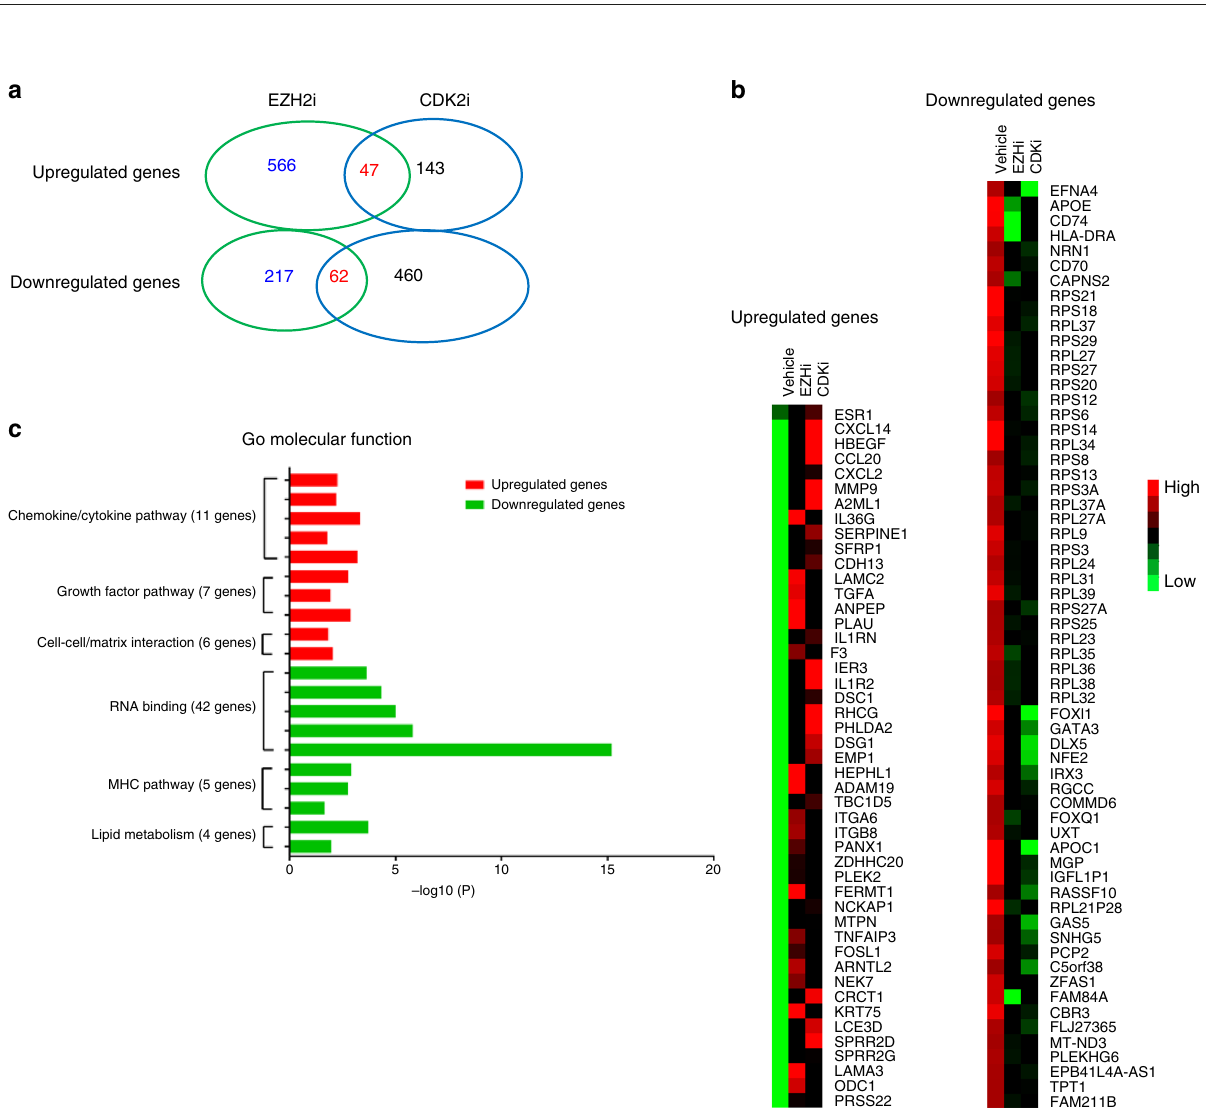
Fig. 4 CDK2/EZH2 blockade creates combination regimen with tamoxifen against TNBC. a Effective inhibition of TBNCs in 3D cultures by combination treatment of CDK2/EZH2 inhibitors (EPZ, GSK; SNS, and DINA) and TAM determined by 3D-Matrigel sphere formation assays. Representative images (upper panel) and bar graph of sphere numbers (bottom panel). Scale bar, 200 μ m. b , c Synergistic effect of combination treatment of the TNBCs in vitro with CDK2/EZH2 inhibitors and TAM b or fulvestrant, Ful c . d , e Inhibitory effect of the combination therapy of CDK2 or EZH2 inhibitor and tamoxifen (TAM) on tumor growth in syngeneic mouse model. 4T1 cells were orthotopically transplanted on Balb/C female mice. The tumor-bearing mice were fi rst pretreated with either EZH2i (EPZ-6438; EPZ) at 34 mg kg − 1 or CDK2i (dinaciclib) at 8 mg kg − 1 daily for 3 days, followed by combined with 4 mg kg − 1 TAM for more than 2 weeks. The tumor burdens were measured with digital caliper ( n = 10). *not signi fi cant, ** p < 0.05, *** p < 0.01, **** p < 0.001, Student ’ s t test. f , g The effects of EZH2 ( f ) or CDK2 ( g ) inhibitor alone or in combination with TAM on TNBC tumor growth in a xenograft mouse model. TNBC SUM-149 cells were orthotopically inoculated on nude mice. The tumor-bearing mice were treated and monitored as described above d , e . EZH2i (GSK343) and CDK2i (dinaciclib) were administered at a dose of 100 mg kg -1 and 8 mg kg − 1 , respectively ( n = 10). *not signi fi cant; *** p < 0.01; **** p < 0.001, Student ’ s t test. h Survival curves of tumor-bearing mice treated with CDK2i, TAM, or their combination ( n = 10). *not signi fi cant, ** p < 0.05, **** p < 0.001, Log-rank test. Source data are provided as a Source Data fi le.